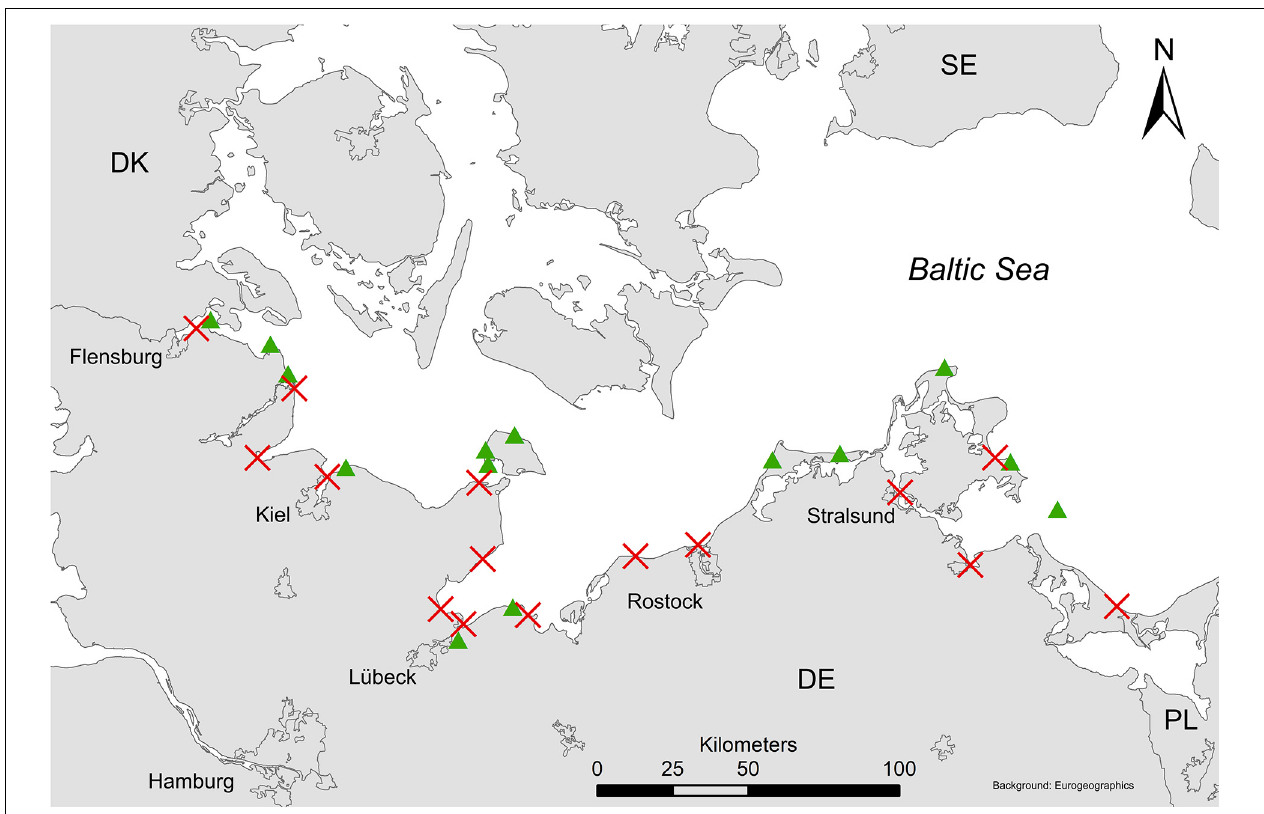
FIGURE 5 | Map of the 15 beaches suggested for a seasonal sand rake method monitoring only (red crosses) and the 14 beaches suggested for the sand rake monitoring implemented into the naked eye OSPAR method monitoring (green triangles).